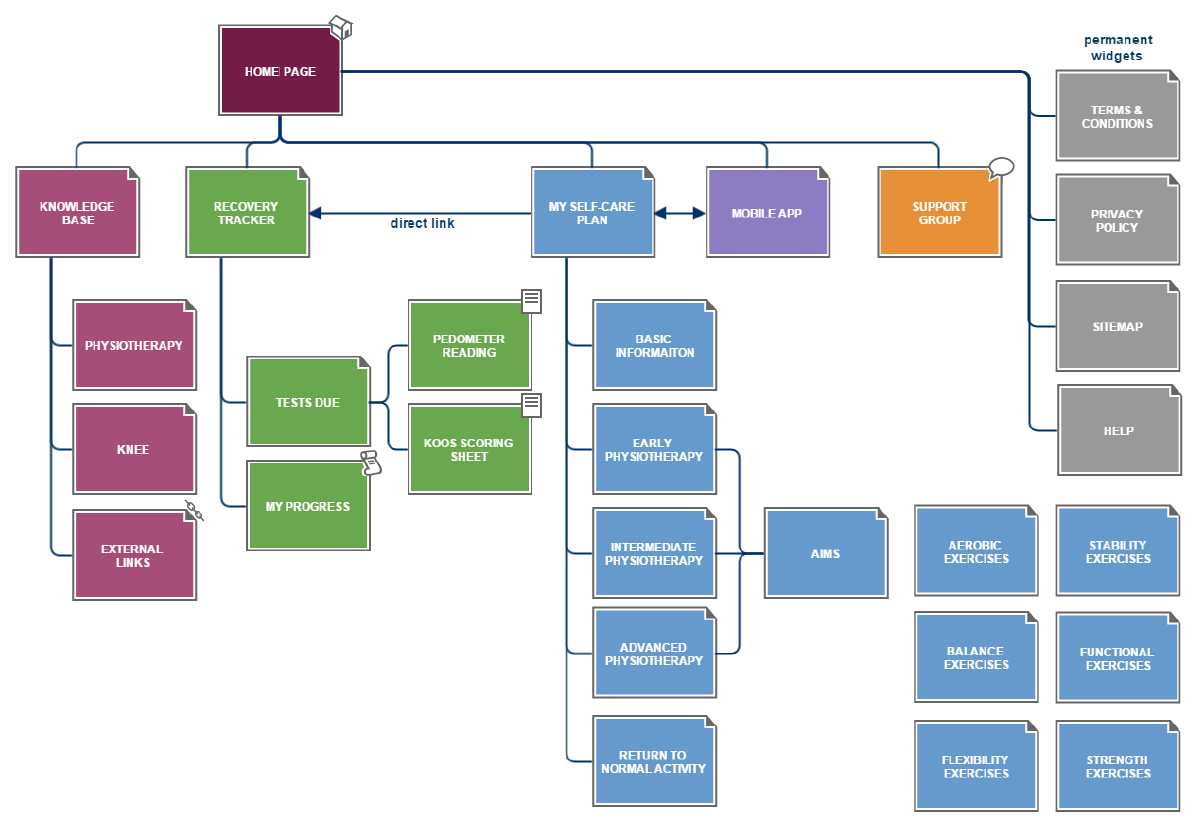
Figure 1. Sitemap of the Facebook